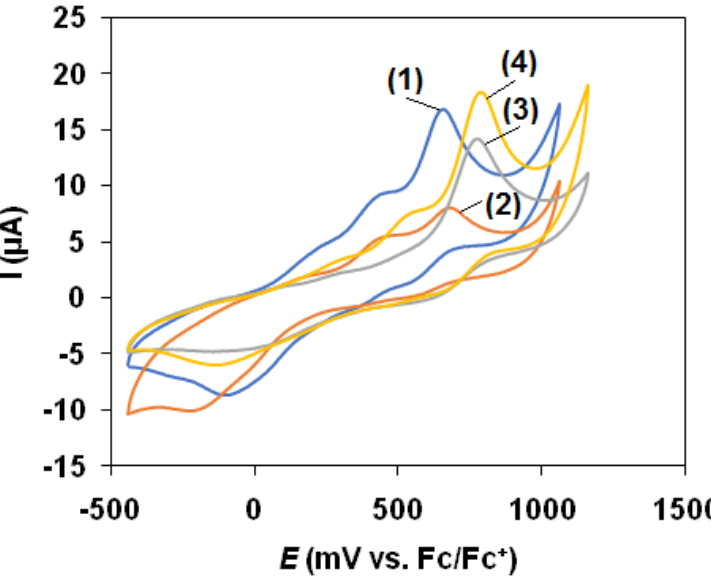
Figure 4. Cyclic voltammograms of [Fe II (L 1–4 )(solvent) 3 ](ClO 4 ) 2 complexes ( 1 – 4 ) (5 mM in acetoni- trile, supporting electrolyte: tetrabutylammonium-perchlorate (0.1 M), scan rate: 100 mV/s).